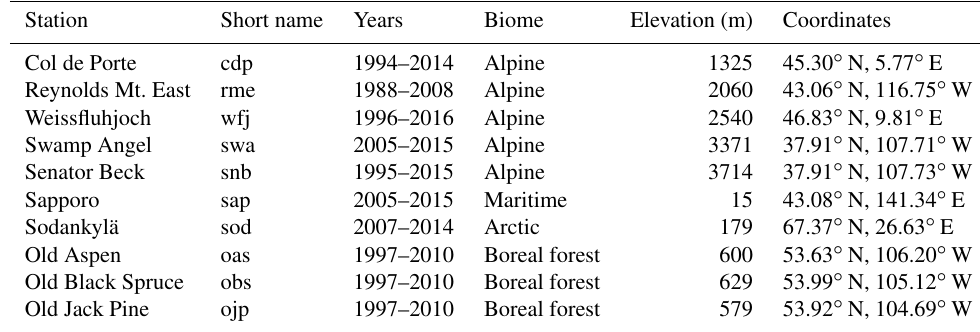
Table 3. List of ESM-SnowMIP sites used for the evaluation of the snow parameters, adapted from Krinner et al. (2018).